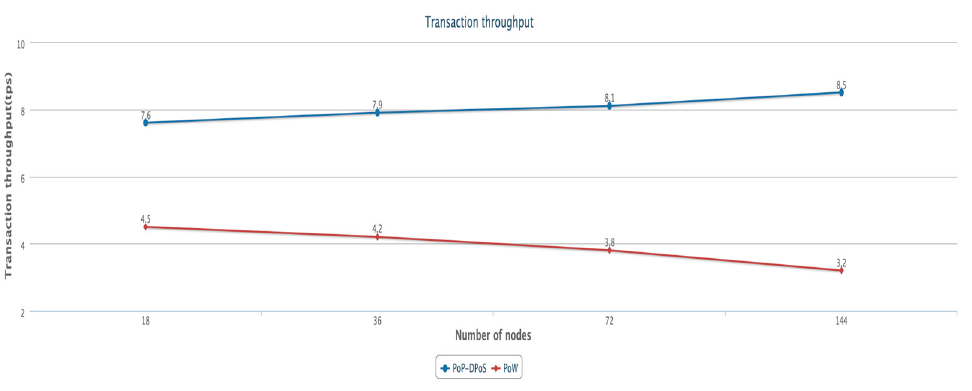
Figure 9. Figure 9. Scalability.